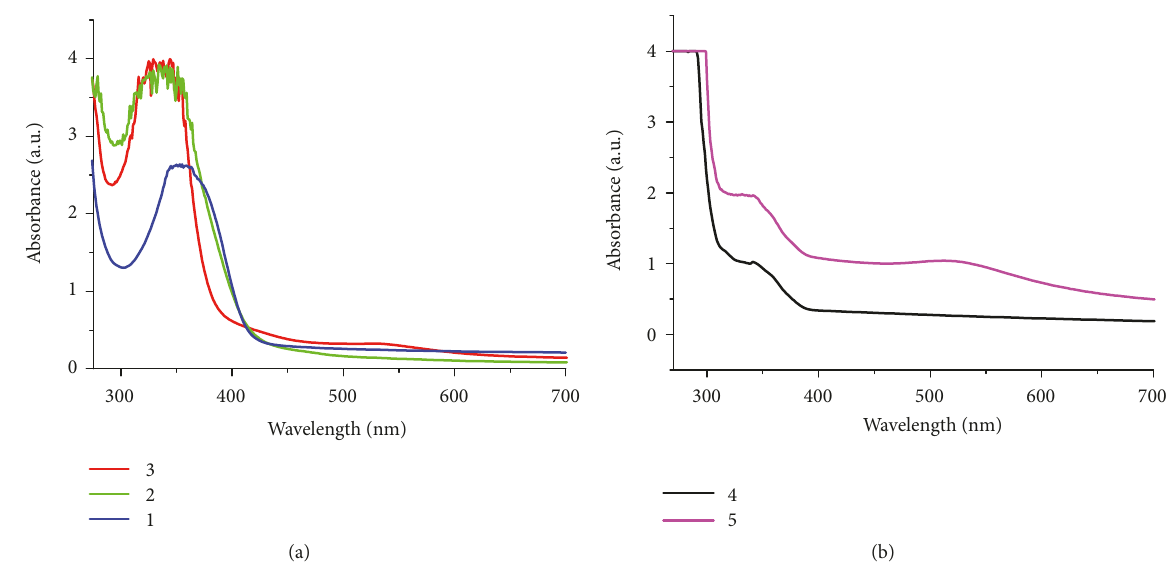
Figure 4: Optical absorption spectra of the ACAIN-containing (compositions 1-3) and polymer films without ACAIN (compositions 4,5).